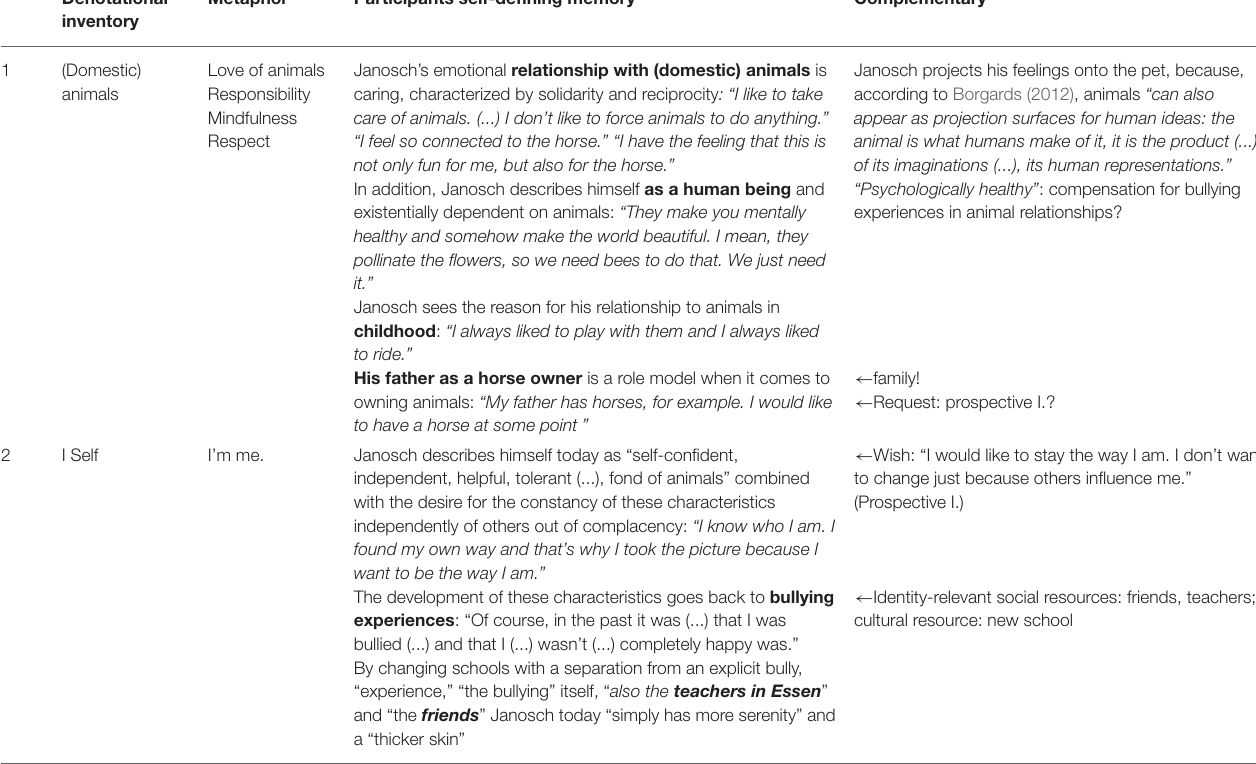
TABLE 1 | Excerpt of Janoschs’ story